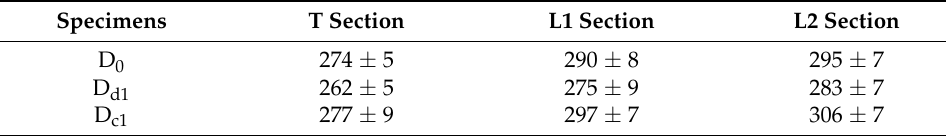
Table 4. Average hardness values (HV 1 ).